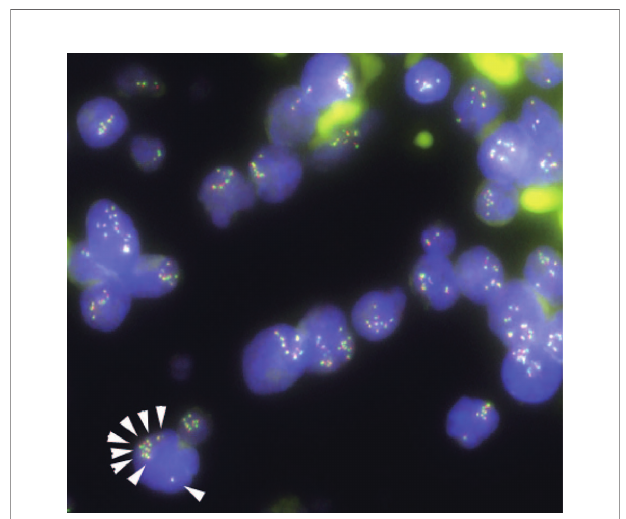
FIGURE 3 | Fluorescence in situ hybridization (FISH) analysis for gene rearrangements involving in the mixed lineage leukemia ( MLL ) gene (11q23) in the present case. MLL FISH data at the time of the initial B-cell acute lymphoblastic leukemia (B-ALL) diagnosis. The full-length MLL gene is shown via a yellow signal, whereas the rearranged MLL gene is shown via a pair of split signals colored green and red. A representative cell in the lower left portion of the fi gure shows eight full-length MLL signals (white arrows) in the nucleus. At the time of initial diagnosis, 91.5% of the interphase cells had at least eight copies of non-rearranged MLL genes. No MLL split signals generated by gene rearrangements were observed throughout the disease